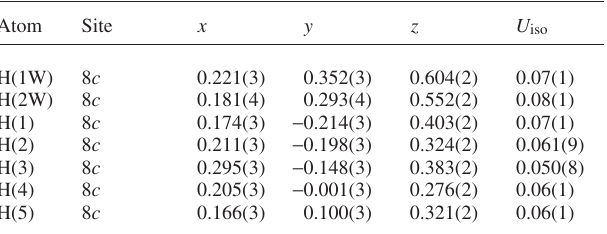
Table 2. Atomic coordinates and displacement parameters (in Å 2 )